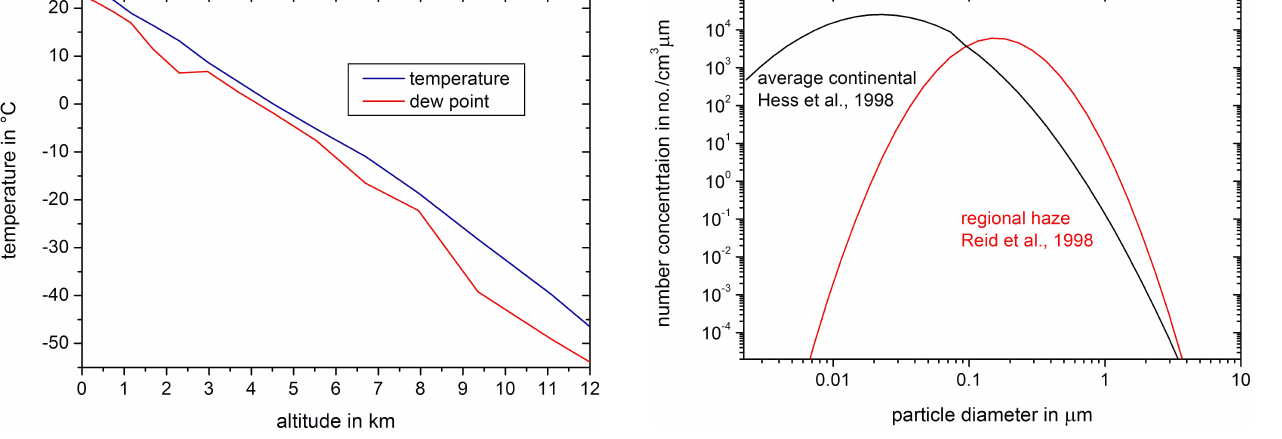
Figure 7. Development of temperature and dew point with altitude during simulations with the air parcel model (B. Langmann, per- sonal communication, 2004).